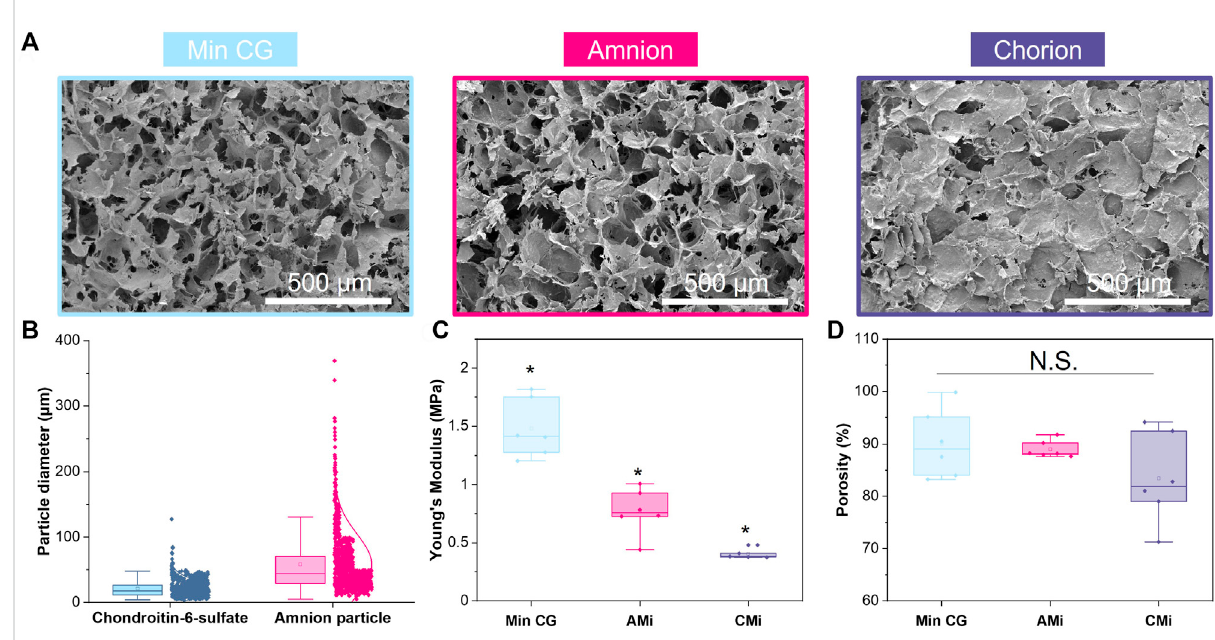
FIGURE 2 Characterization of mineralized collagen (MC), amnion or chorion incorporated membrane (AMi, CMi, and respectively) particle scaffolds. (A) Scanning electron microscopy (SEM)images ofmineralizedcollagen, mineralized collagen-amnion,andmineralizedcollagen-chorionscaffolds. (B) Pulverized amnion and chorion particle size compared to the particle size of the glycosaminoglycan in the scaffolds. (C) Compression testing of mineralized collagen scaffold variants using an Instron mechanical tester ( n = 6). * indicates all groups are signi fi cant from one another ( p < 0.05). (D) Porosity as measured by wet-dry weights using